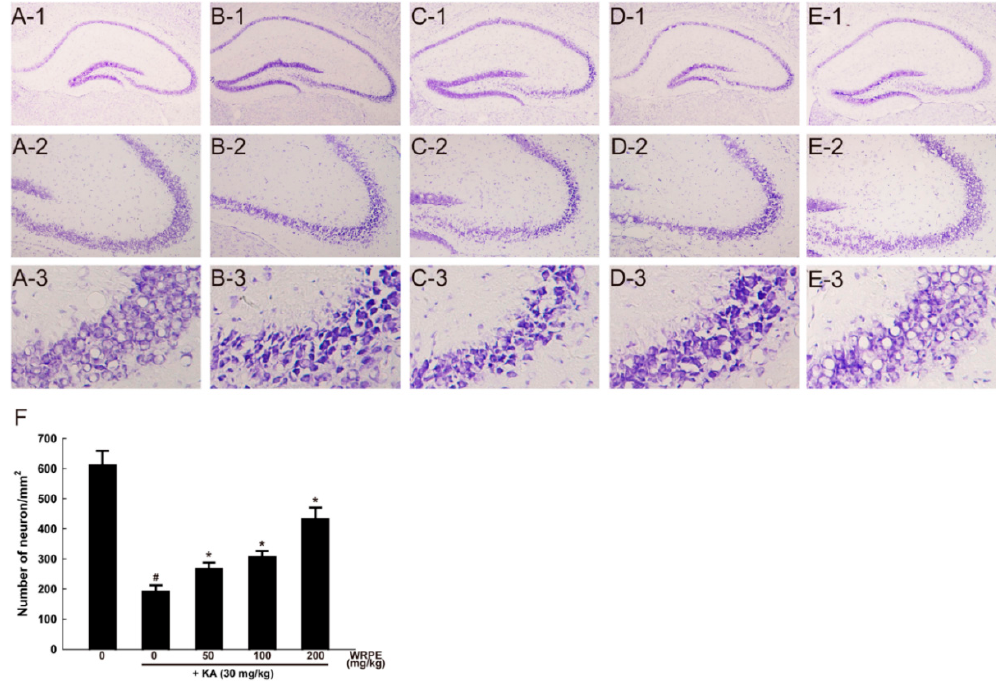
Figure 6. Neuroprotective activity of white rose petal extract (WRPE) in kainic acid (KA)-challenged mice observed by cresyl violet staining, showing representative microscopic findings ( A – E ) and the number of survived cells ( F ). ( A ) Normal (vehicle) control, ( B ) KA (30 mg/kg) alone, ( C ) KA + WRPE (50 mg/kg), ( D ) KA + WRPE (100 mg/kg), and ( E ) KA + WRPE (200 mg/kg). ( F ) Cresyl violet-positive neurons with normal appearance in the hippocampal CA3 pyramidal cell layer were counted. n = 3 per treatment group. # Significantly different from normal control ( p < 0.05). * Significantly different from vehicle control ( p < 0.05).